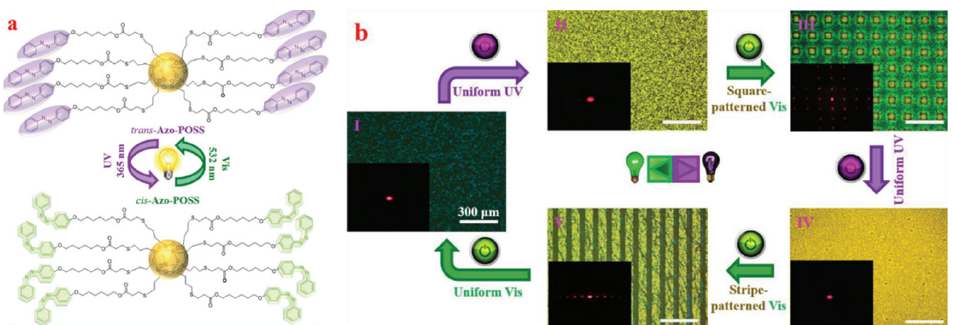
Figure 13. ( a ) Light-driven reversible transition between the self-organized BPII soft simple cubic lattice and the helical superstructure. ( b ) Fabrication of biphasic micropatterns containing BPII and N* under alternating UV and visible light irradiation [115]. Light-Driven Reversible Transformation between Self-Organized Simple Cubic Lattice and Helical Superstructure Enabled by a Molecular Switch Functionalized Nanocage from Zhou, Adv Mater, published by John Wiley and Sons.